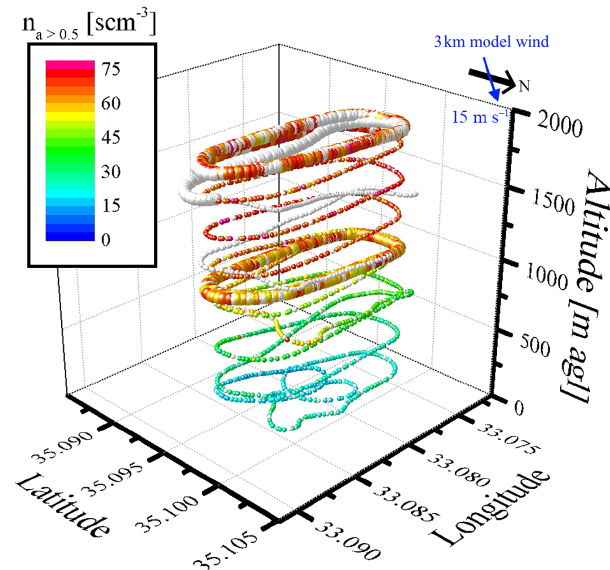
Figure 16. Flight track of the first Cruiser flight on 9 April. Colored spheres give the total number concentration of particles larger than 0.5µm (white: no measurement available). Larger-sized spheres indicate when sampling was carried out. The 3000m wind at 06:00UTC from DREAM (Movie S1) is given by the blue